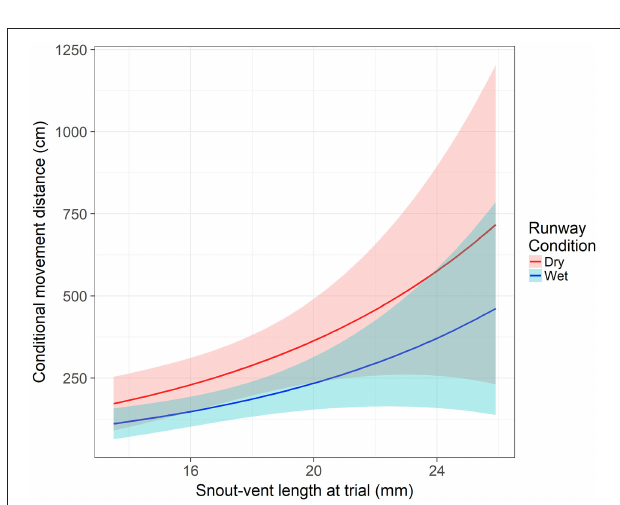
FIGURE 3 | The impact of snout-vent length and runway condition on movement distance after crossing the movement hurdle. Shaded areas represent the 95% confidence interval. Response is modeled off an individual from the permanent hydroperiod in their first runway assay with average body condition and time since